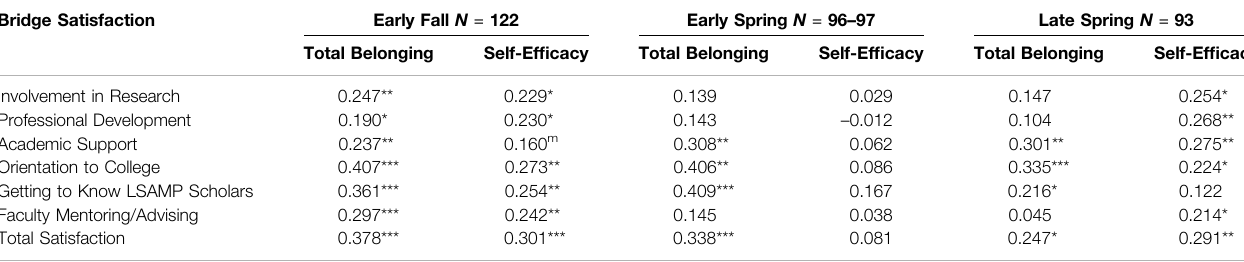
TABLE 2 | Bridge Satisfaction Correlated with Total Belonging and STEM Self-Ef fi cacy.